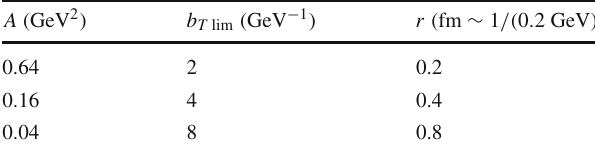
Table 1 Values of the parameter A used in Eq. (17) for e − S NP , along with the corresponding b T lim and r at M QQ = 12